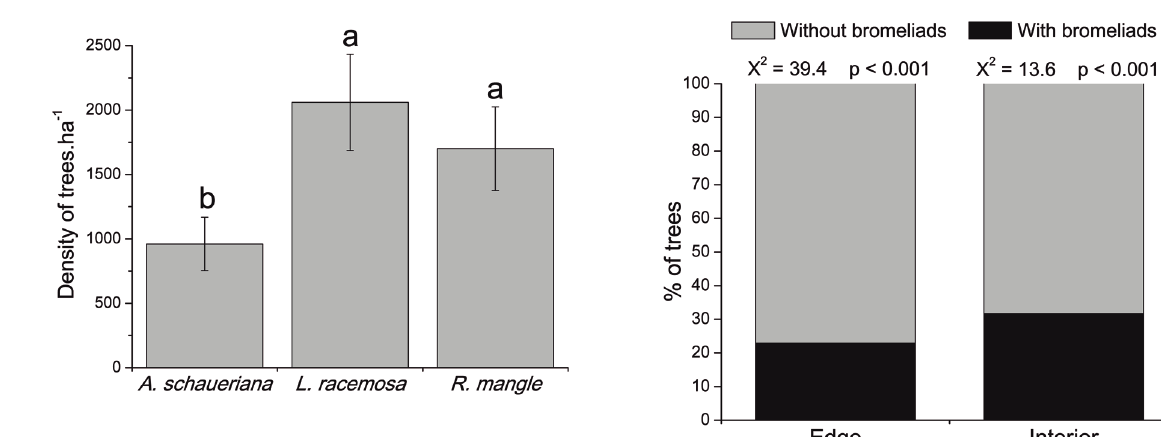
Figure 1 - Density of each tree species (mean and standard error in ha -1 ) in Itapanhaú